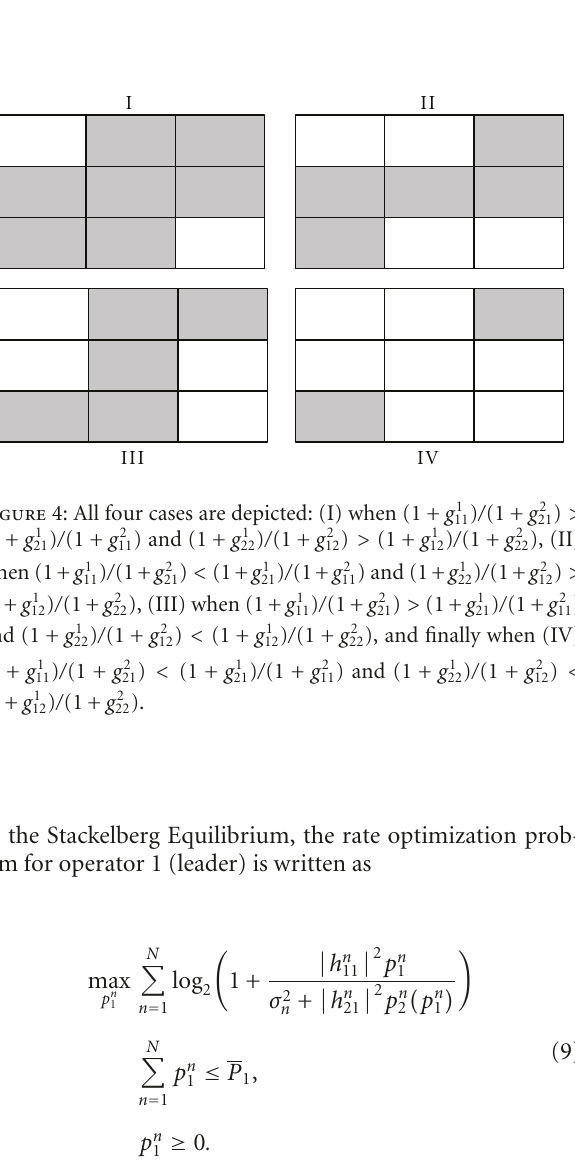
Figure 3: Characterization of the Nash equilibria regions given a set of channel realizations h .